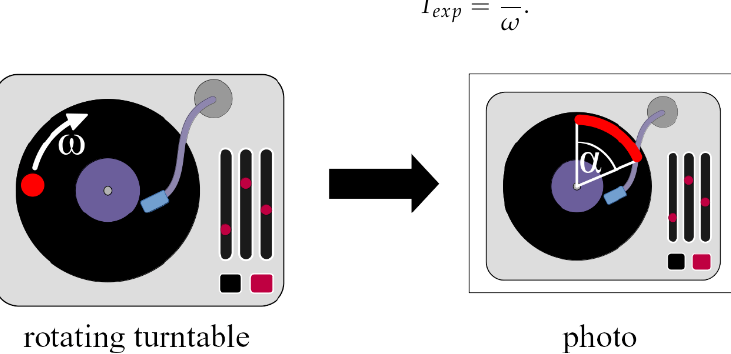
Figure 7. Motion blur method with a rotating object on a turntable. The measurement equipment and a photo taken with T exp = 1/10 s can be seen in Figure 8.